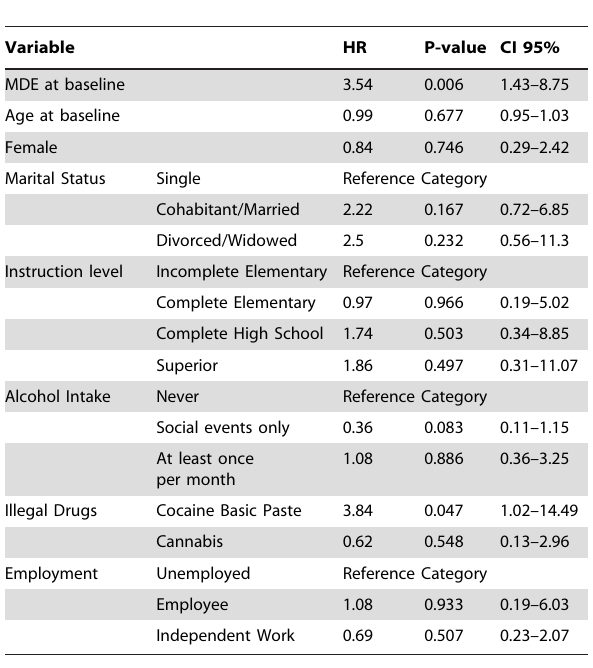
Table 6. Model of MDE as hazard factor for Negative outcomes controlling by age, sex, instruction level and marital